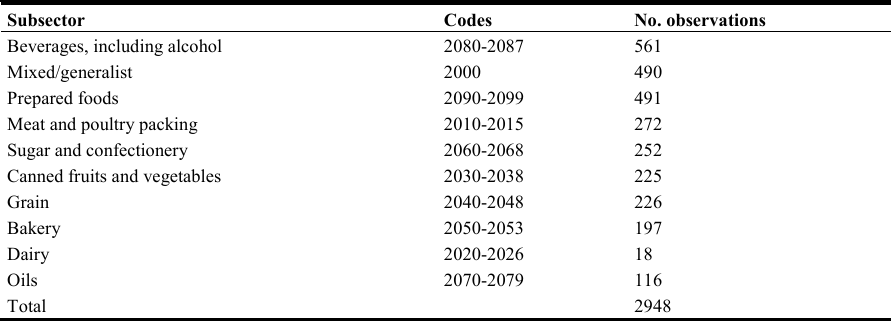
Table 2 Sample composition - observations per subsector Subsector Codes No.